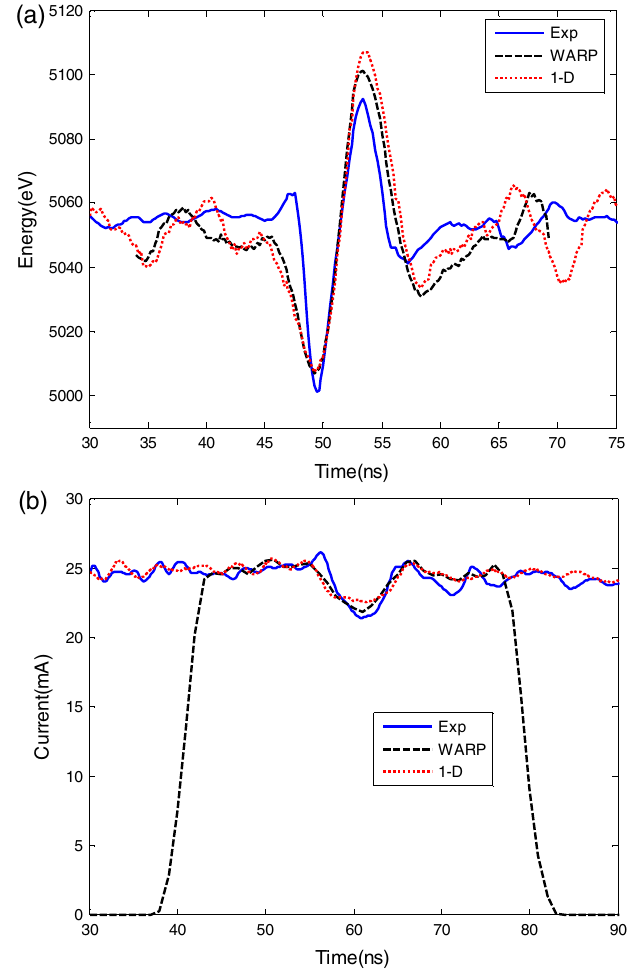
FIG. 8. (Color) Comparison of results from the experiment (blue solid lines), WARP (black broken lines), and 1D theory (red dotted lines) for the 25 mA beam: (a) mean energy profiles at LC2; (b) current profiles at